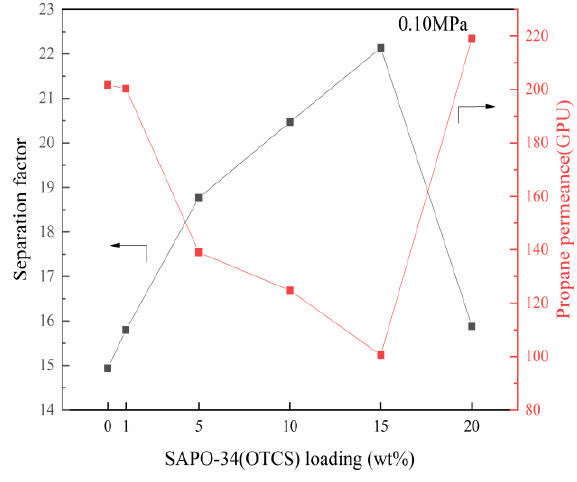
Figure 8. Effects of SAPO-34 (OTCS) loading on separation performance.